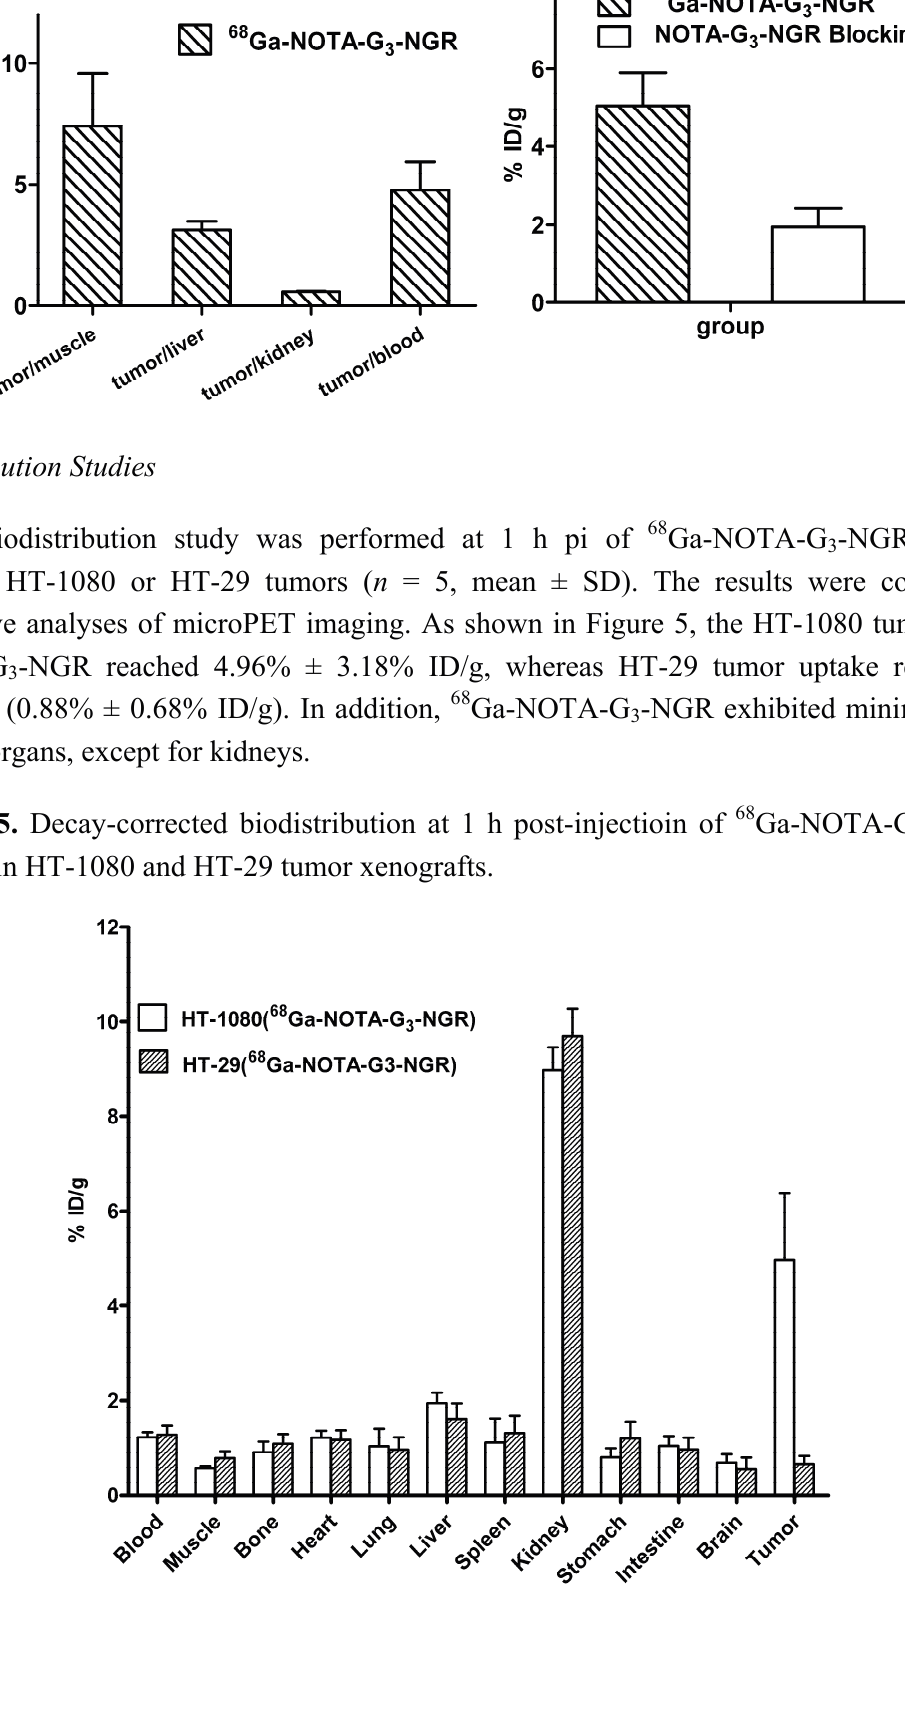
Figure 4. ( a ) The T/NT ratios at 1 h pi quantified by microPET imaging; ( b ) The tumor uptake of 68 Ga-NOTA-G -NGR peptide with the non-radiolabeled peptide vs. without the 3 non-labeled peptide at 1 h pi quantified by microPET imaging.